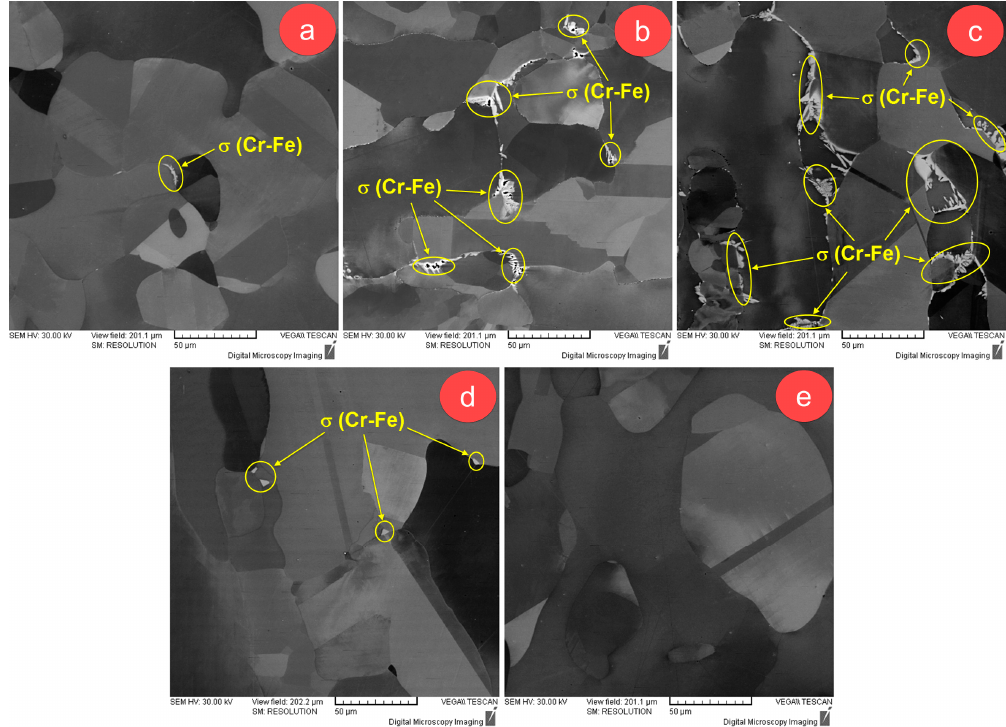
Figure 2. SEM-BSE micrographs of: ( a ) as-forged UNS S32750/1.4410/F53 SDSS alloy; ( b ) solution-treated (ST) at 800 °C for 0.6 ks; ( c ) ST at 900 °C for 0.6 ks; ( d ) ST at 1000 °C for 0.6 ks; ( e ) ST at 1100 °C for 0.6 ks.